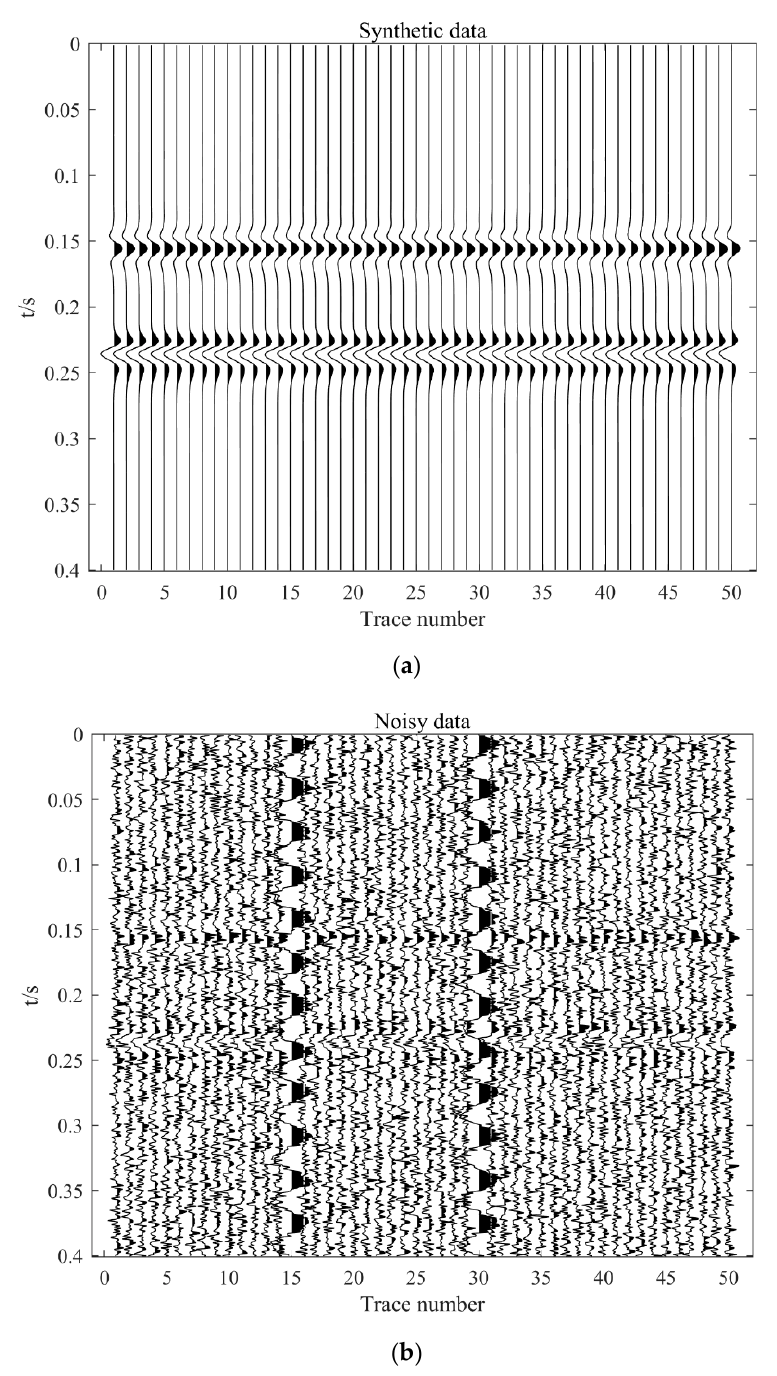
Figure 7. ( a ) Synthetic seismic data without noise; ( b ) seismic data with noise added.